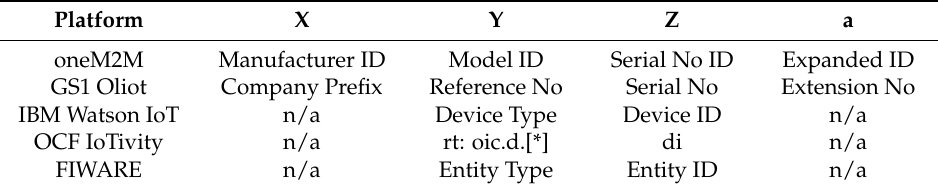
Table 4. Mapping table for the device IDs of various IoT platforms.